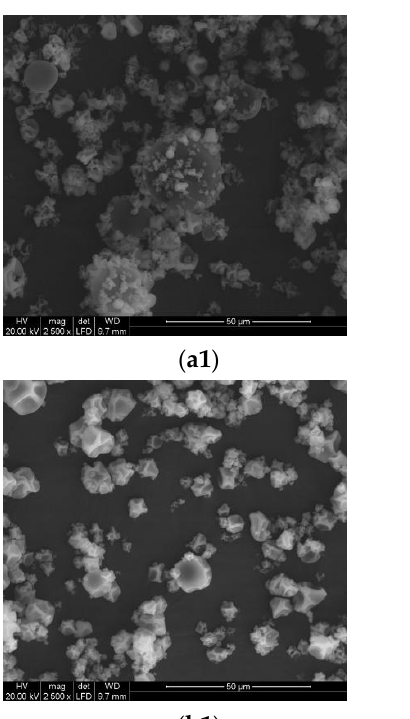
Figure 3. SEM images of ( a ) sd_S and ( b ) sd_SMT. Magnification ( 1 ) 2500×; ( 2 ) 10,000×.